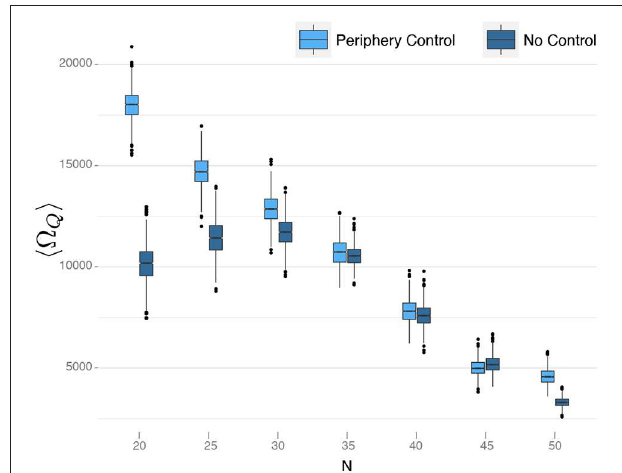
FIGURE 6 | Comparison of different periphery control approaches with fixed control signal. The effectiveness of the control method without adapting the signal to the size of the network decreases with size. In the figure are plotted bootstrap samples for h (cid:127) Q i obtained from 100 simulations for each network size and each strategy. The control signal used is u = −